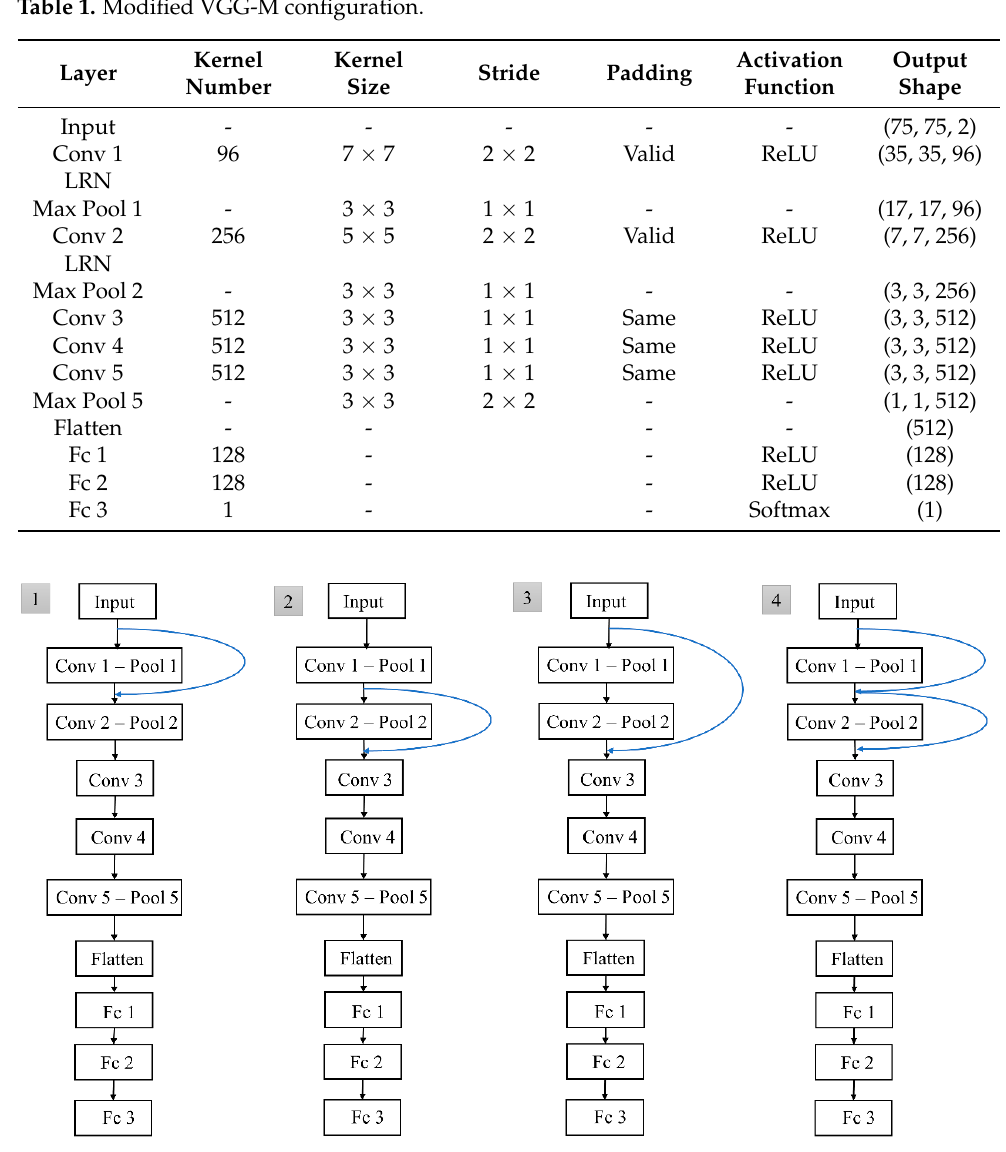
Figure 7. Four variations of the proposed feedforward networks. ( 1 ) Variation 1 uses a skip connection over a single layer applied to the first convolution layer input, ( 2 ) Variation 2 uses a skip connection over a single layer applied to the second convolution layer input, ( 3 ) Variation 3 uses a skip connection over two layers applied to the first convolution layer input, and ( 4 ) Variation 4 uses two skip connections over a single layer applied to the first and second convolution layer